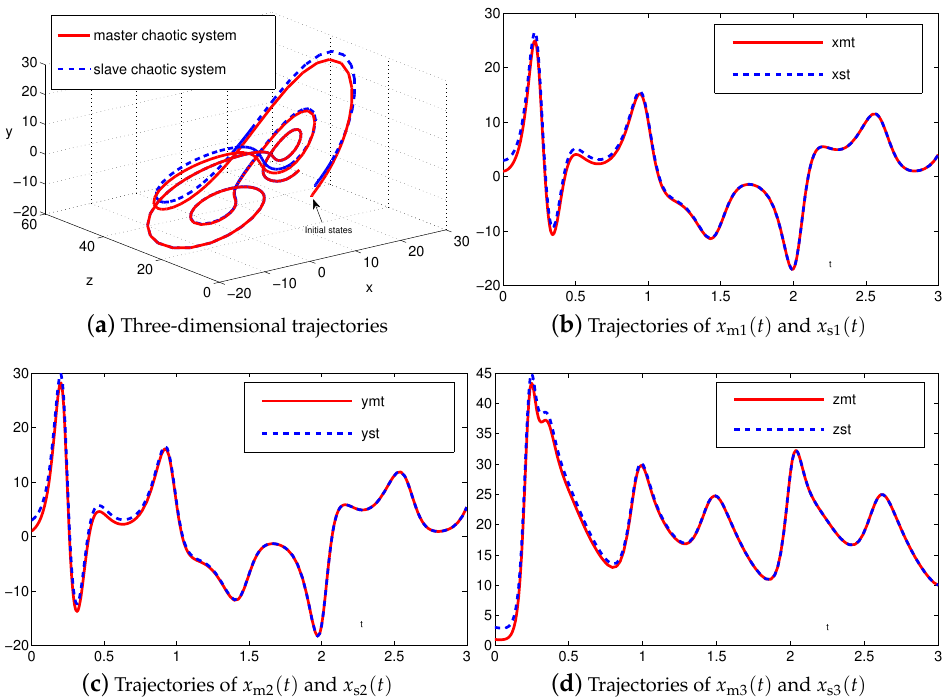
Figure 8. Synchronization performance between two nonidentical chaotic systems (24) and (28) equipped with controller (6) via the proposed SEZN approach.